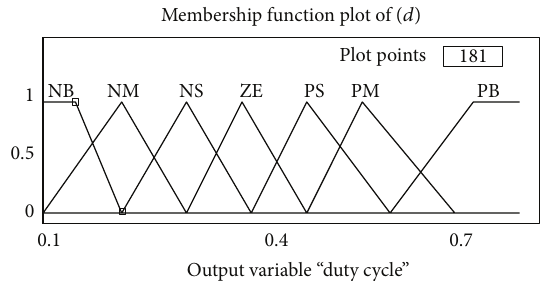
Figure 14: Graphical view of the membership function for duty